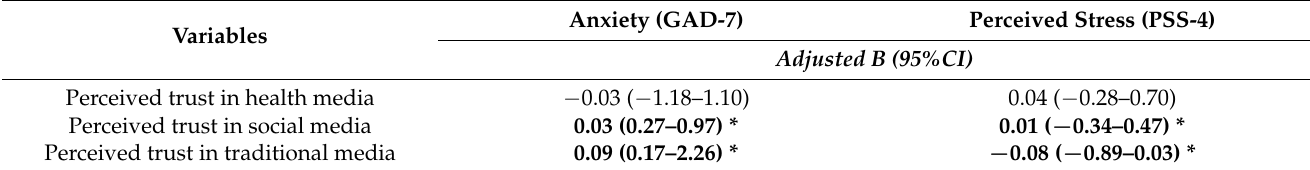
Table 4. Regressing mental health on perceived trust in COVID-19 information sources ( n =